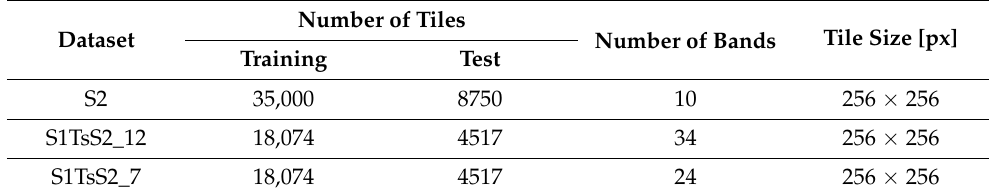
Table 1. The different subsets built from the S2 and S1TsS2 datasets. Number of Dataset